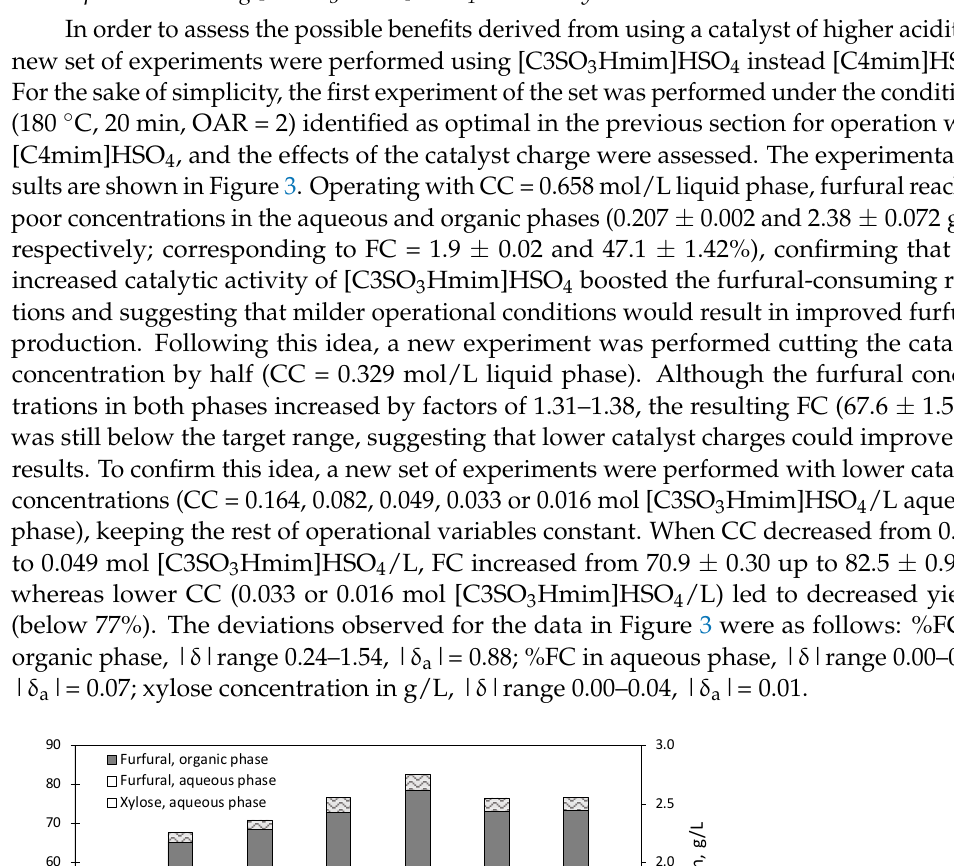
Molecules 2022 , 26 , x FOR PEER REVIEW 6 of 11 Figure 2. Molar conversions of potential substrates into furfural (FC) and xylose concentrations, obtained at 180 °C in experiments using [C4mim]HSO 4 as a catalyst. Results were obtained at di- verse reaction times in media containing 0.847 mol [C4mim]HSO 4 /L aqueous phase. In related studies dealing with the manufacture of furfural from commercial xylose in biphasic media, Peleteiro et al. [36] reported FC around 71% in water/toluene or